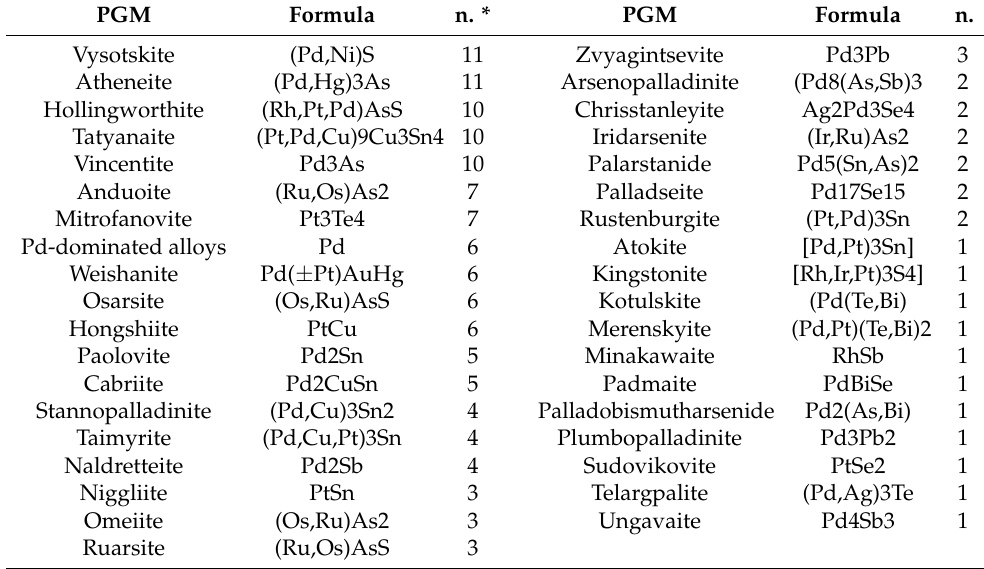
* Number of grains.